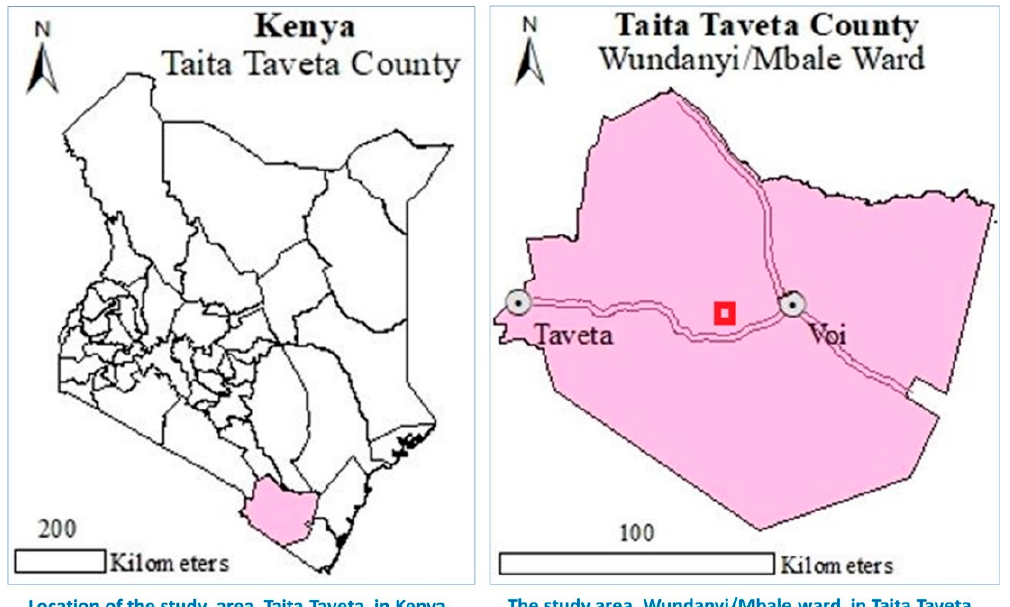
Figure 2. The location of the study area from national and local contexts (Source: Authors’).